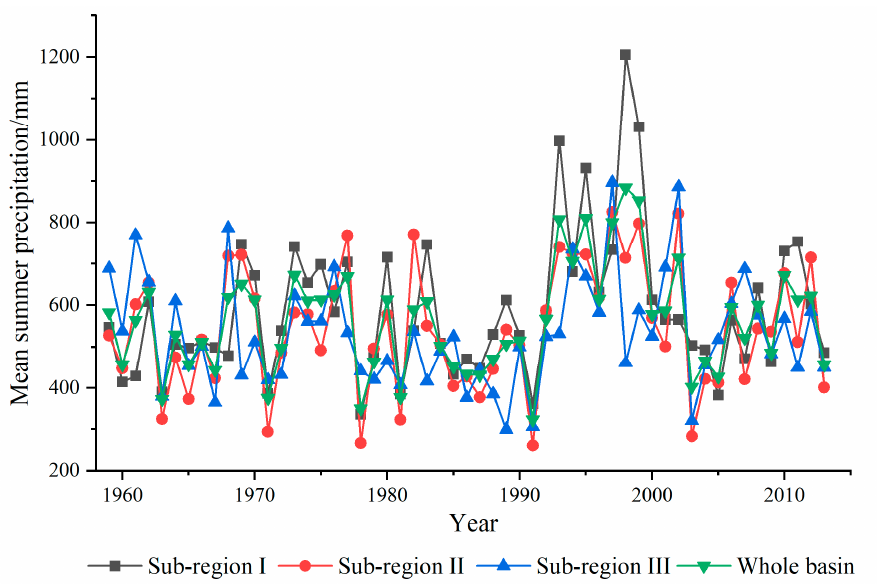
Figure 5. Time series of mean summer precipitation averaged over the three sub-regions and the whole basin.